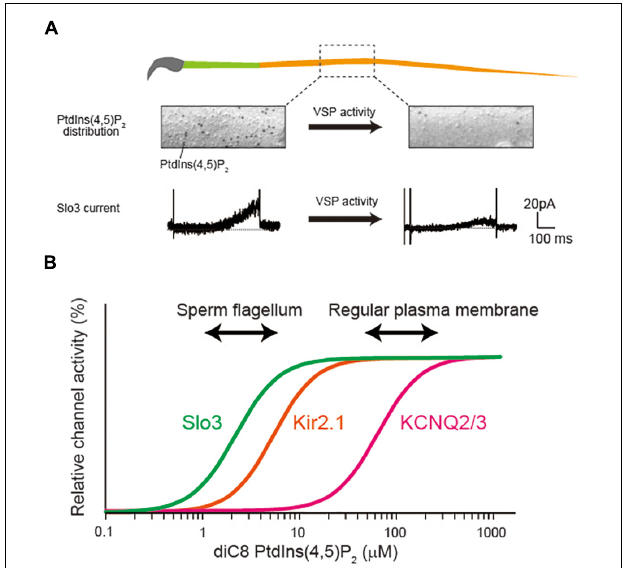
FIGURE 1 | Possible relationship between PtdIns(4,5)P 2 concentration and its affinity for ion channels. (A) Voltage-sensing phosphatase (VSP) reduces the PtdIns(4,5)P 2 levels in sperm flagellum, regulating Slo3 activity. The figure is illustrated based on the finding in our previous report (Kawai et al., 2019). The PtdIns(4,5)P 2 is detected by freeze-fracture electron microscopy. The VSP changes the distribution of PtdIns(4,5)P 2 levels and regulates Slo3 activity. The Slo3 activity was measured by perforated patch clamp recording (Kawai et al., 2019). (B) Diagram showing the different PtdIns(4,5)P 2 dependency among different ion